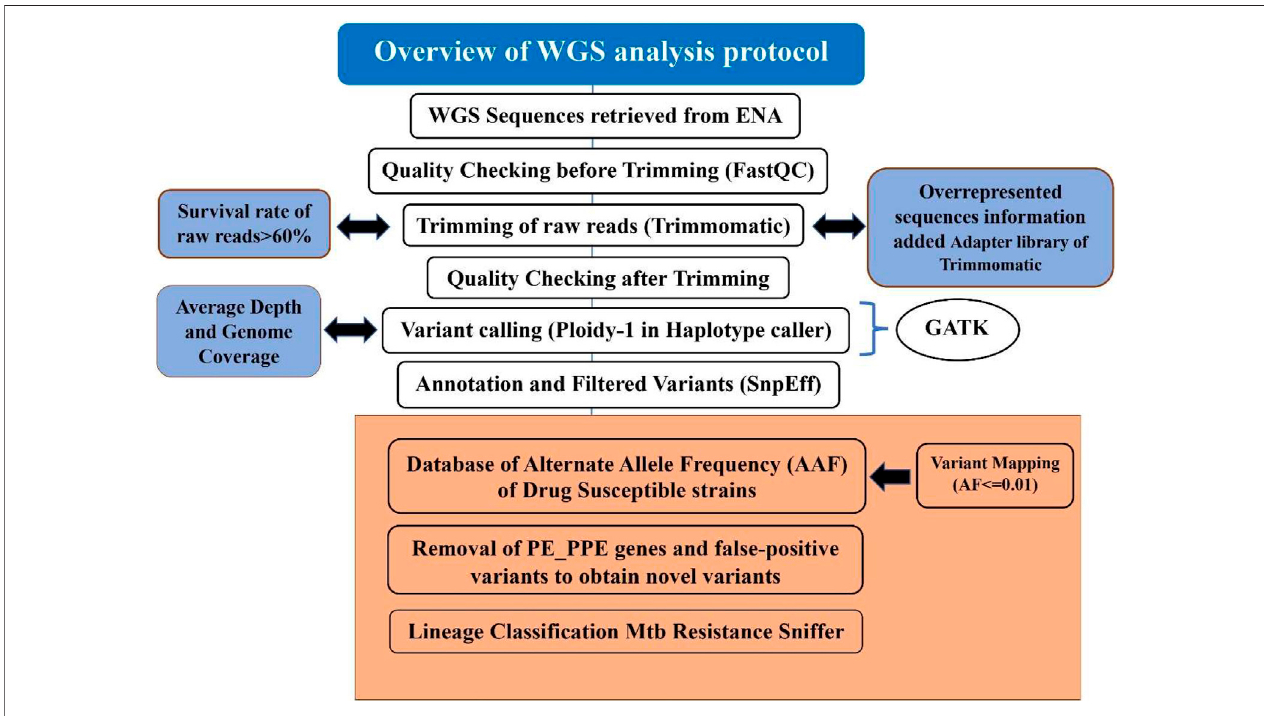
FIGURE 1 | Step-by-step procedure of the MycoVarP pipeline for Mtb whole-genome approach. The text represented in the work fl ow shows the steps which are not included in any other existing WGS Mtb pipelines. The box present in orange shows the steps involved in variant prioritization such as mapping the query sample against the drug-susceptible database and removal of intrinsically disordered region (IDP) protein family-like PE/PPE genes and false-positive